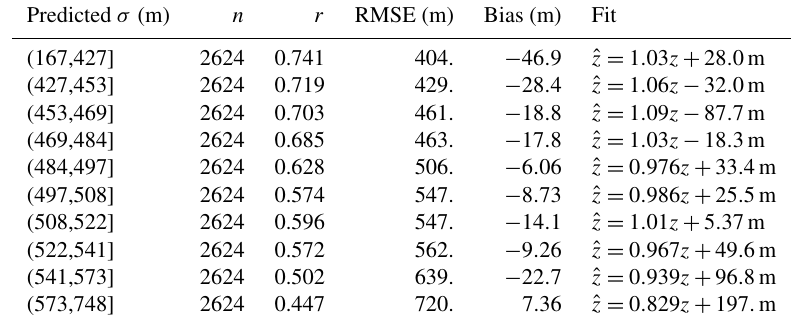
Table 4. CBASE cloud base statistics by decile of predicted uncertainty; see Table 2 for a description of the statistics provided.